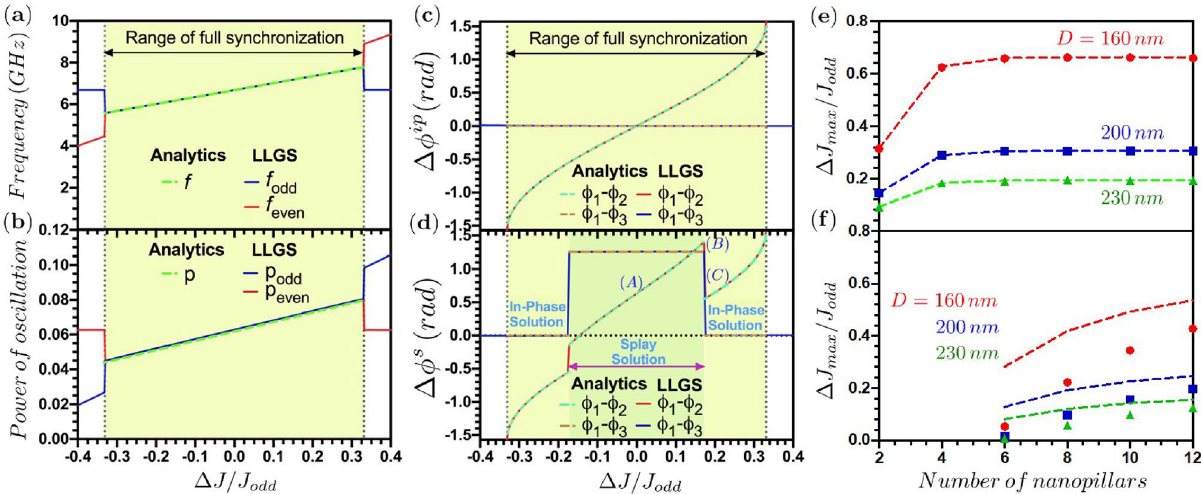
Figure 2. Dependence of ( a ) the frequency and ( b ) the power of oscillation on the normalized current density 1 10 11 A / m 2 . In the macrospin simulations first the in-phase or splay modes mismatch (cid:31) J / J odd with J odd = − × were established at zero mismatch and then J even was varied. Both modes result in the same frequency and power vs. mismatch (up to 1% accuracy). Phase difference �φ as a function of the current density mismatch, when starting the system ( c ) in the in-phase and ( d ) the splay state. For the subfigures ( a – d ), we consider 10 and D 160 nm; and the vertical gray dotted-lines indicate the limits of the full synchronisation range, N = = π/ 2 , see Eq. (13). The point (A) in ( d ) represents where the phase difference between the closest STNOs is ± the starting-point of the macrospin simulations when the current density mismatch is zero. The point (B) in ( d ) 1.174 10 11 A / m 2 ). The corresponds to the transition between the splay to the in-phase solutions ( J even = − × point (C) in ( d ) corresponds to the situation when the phase difference between the STNOs follows the in-phase solution. Locking range in terms of maximum current density mismatch for ( e ) the in-phase mode and ( f ) the splay mode as a function of the number N of STNOs and for different separations D between STNOs. Full dots are results from the numerical simulations and the dashed lines join the analytical solutions and guide the